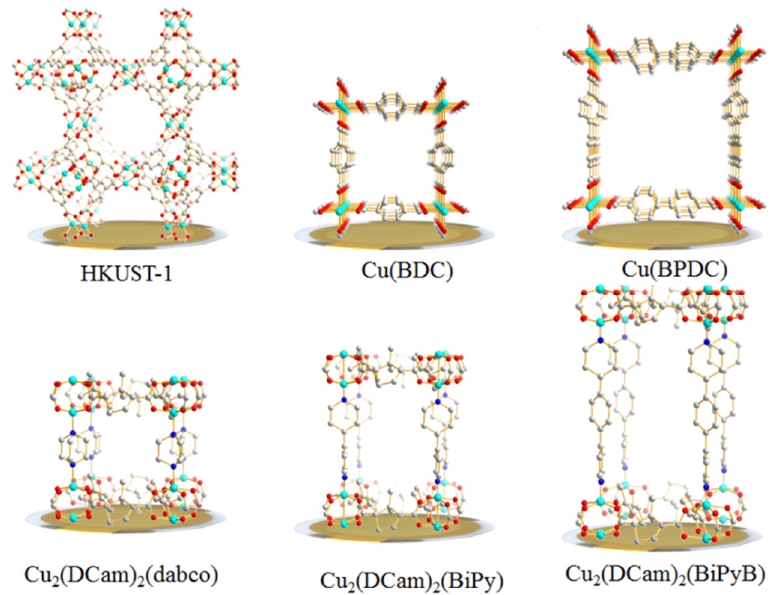
Figure 1. The six different SURMOF structures of the sensor array used in the e-Nose system, namely HKUST-1, Cu(BDC), Cu(BPDC), Cu 2 (DCam) 2 (dabco), Cu 2 (DCam) 2 (BiPy), and Cu 2 (DCam) 2 (BiPyB).